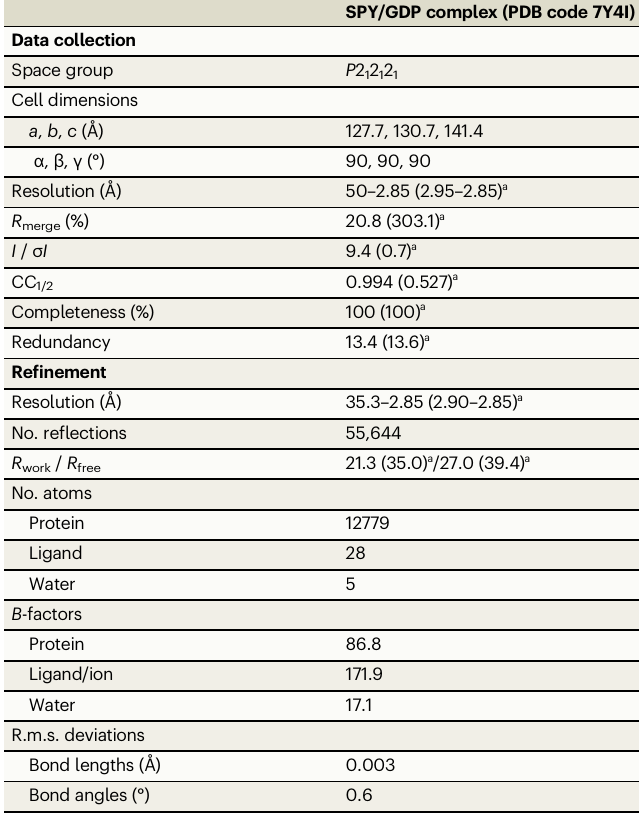
Table 1 | Statistics of X-ray diffraction and structure re fi